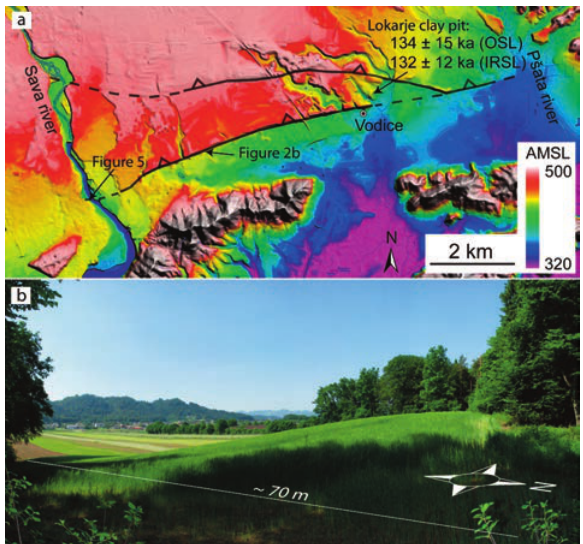
Figure 2. (a) Surface expression of the Vodice fault as seen on the DEM 5 m (Public Information of Slovenia, the Surveying and Map- ping Authority of the Republic of Slovenia, DEM 5, 2006). Loca- tions of Figure 2b and Figure 5 are indicated as well as the location of the dating sampling site. (b) Field picture of the southern Vodice scarp (view from the top of the scarp towards southwest). See Fig- ure 2a for location of the picture.